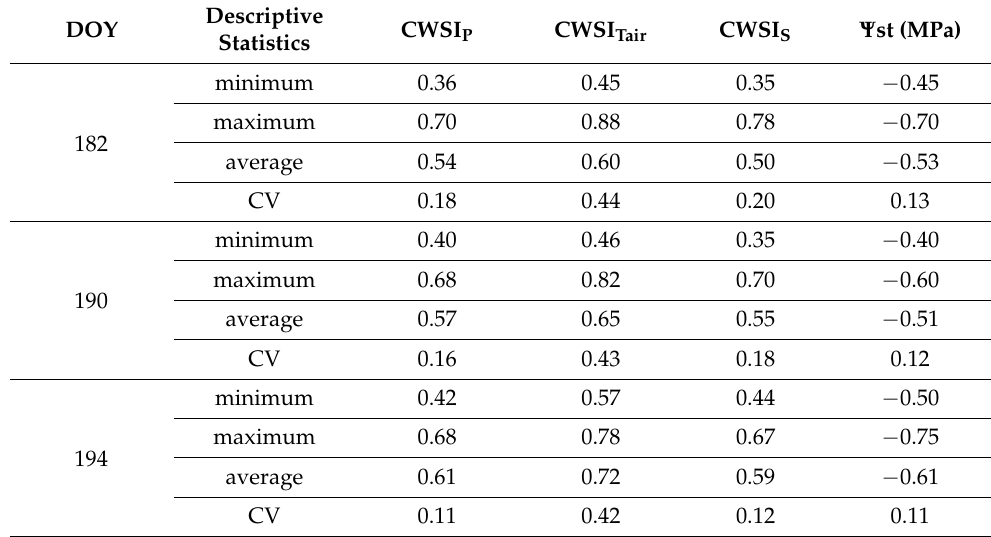
Table 3. Statistics for CWSI portable (CWSI P ), CWSI air temperature (CWSI Tair ), CWSI simplified (CWSI S ), and water potential ( Ψ st) for the three DOY.